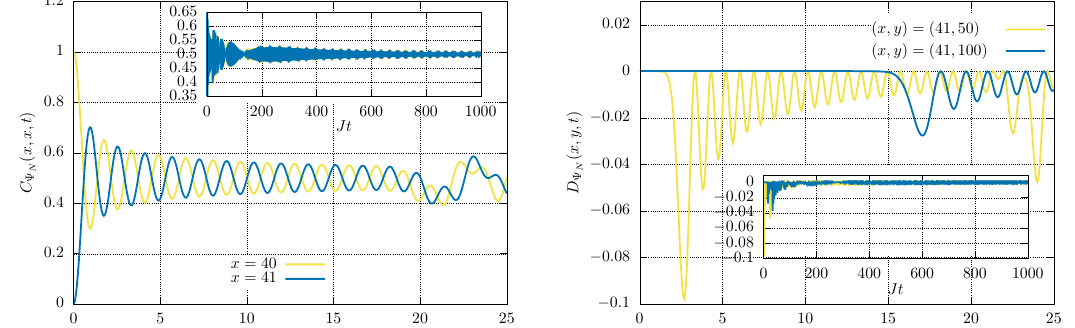
0 . − 0 . 04 − 0 . 06 − 0 . 08 − 0 . 1 −